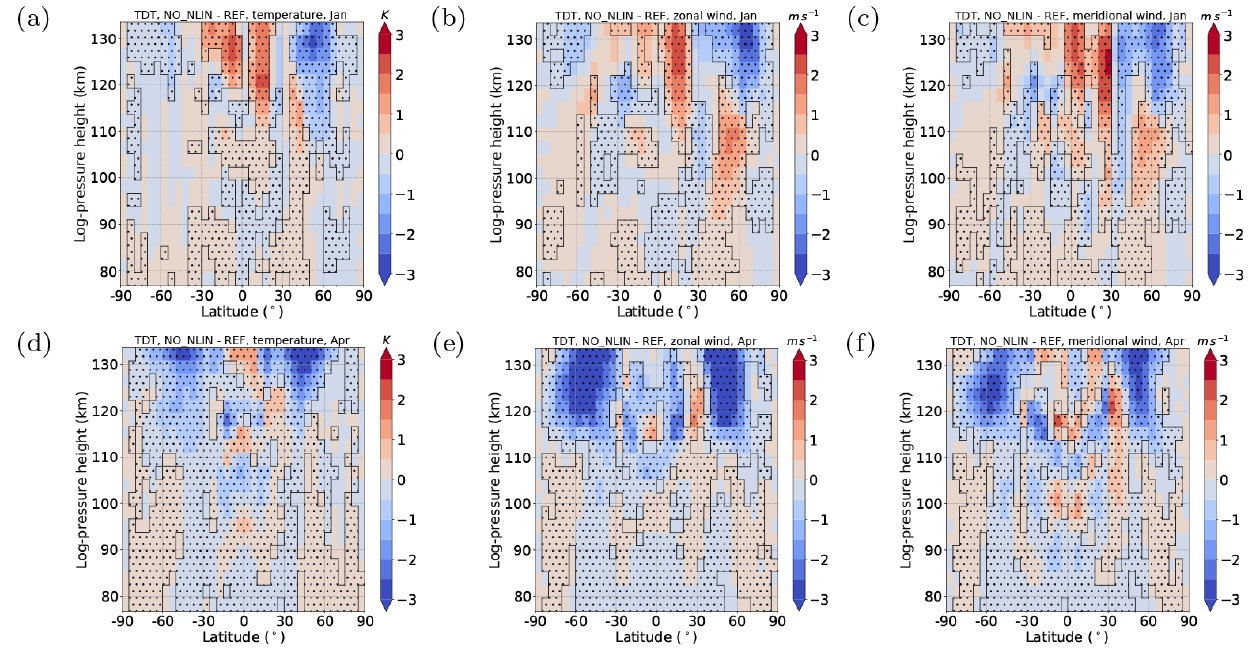
Figure 10. Difference of TDT amplitudes between NO_NLIN and REF simulation. Red colors denote larger NO_NLIN simulation ampli- tudes and blue colors denote larger REF simulation amplitudes. Significant areas ( α < 0 . 01) are hatched. (a, d) Temperature, (b, e) zonal